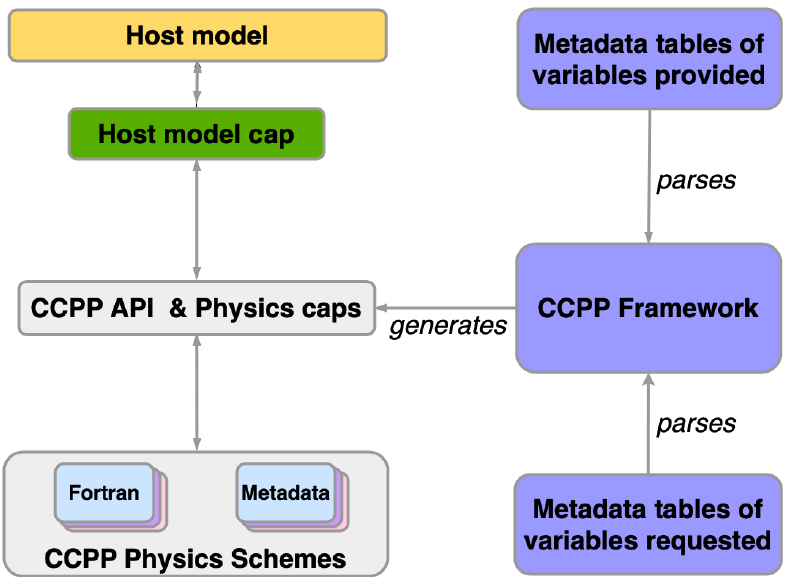
Figure 1. Architecture of the CCPP and its connection to a host model. The CCPP Framework auto-generates the CCPP API and physics caps that connect the schemes in CCPP Physics with the host model through a host model cap/CCPP